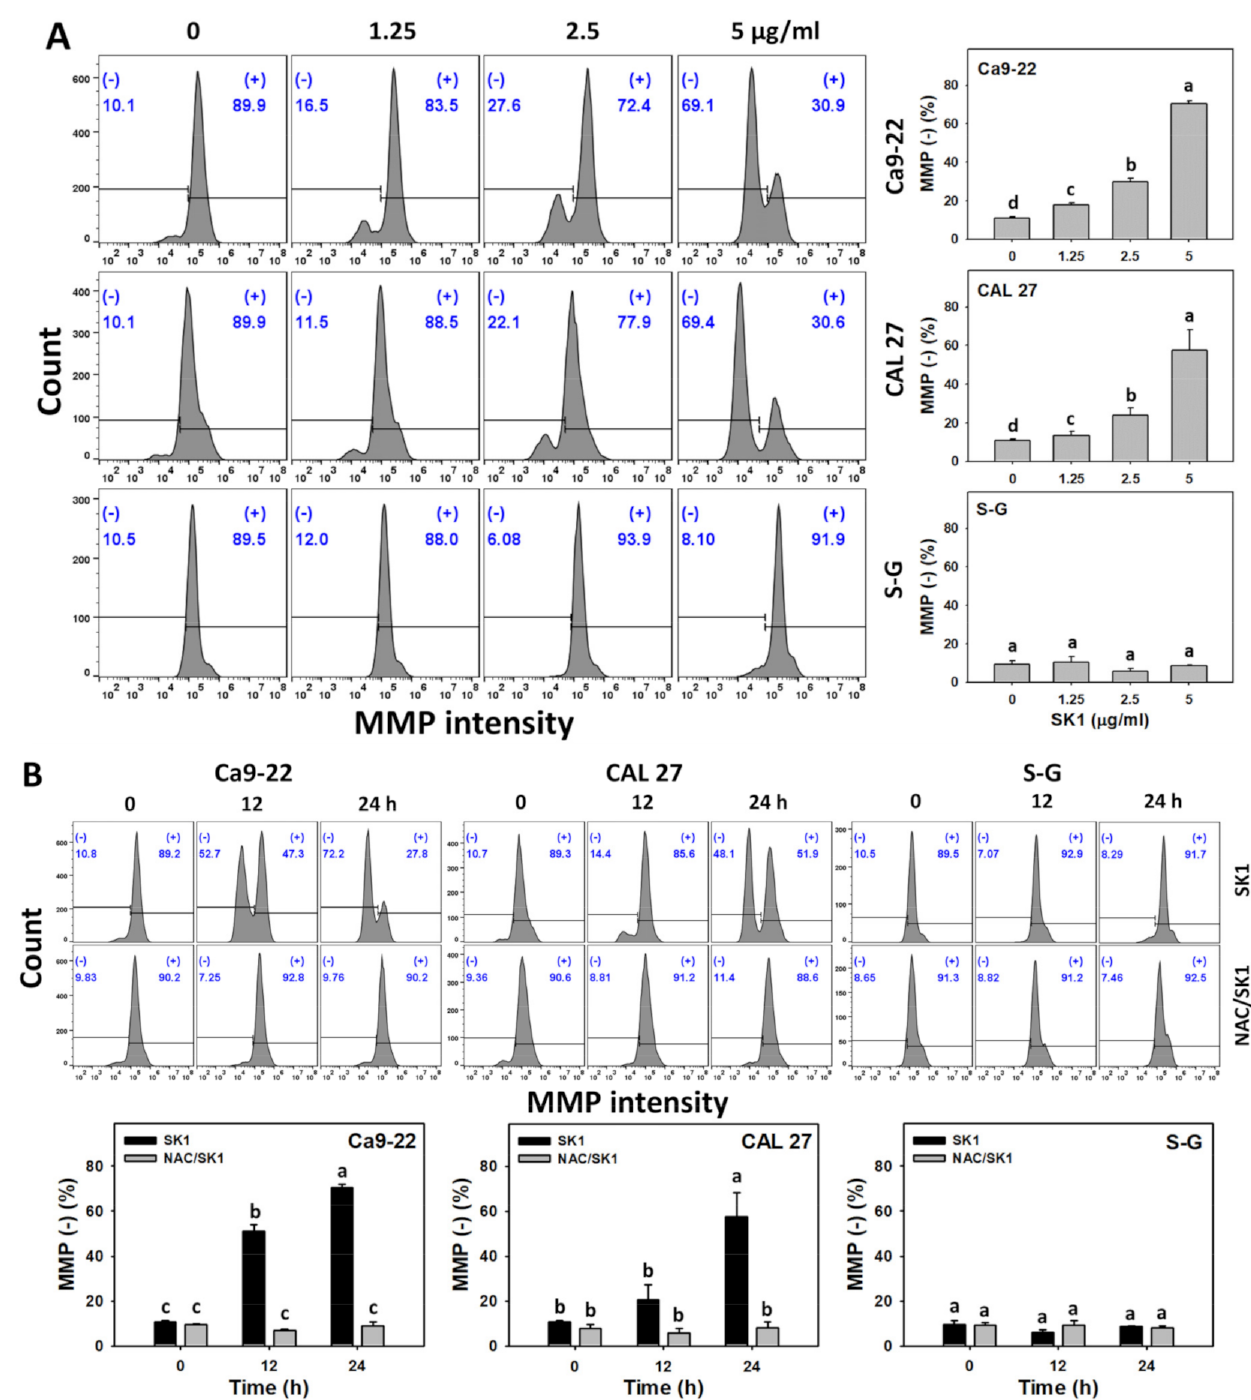
Figure 7. Oxidative stress effects (MMP) of SK1. ( A ) MMP assays of SK1. Non-malignant (S–G) and oral cancer (Ca9-22 and CAL 27) cells were treated with SK1 (0 (0.1% DMSO in medium), 1.25, 2.5, and 5 µ g/mL) for 24 h. ( B ) MMP assays of NAC/SK1. NAC/SK1 indicated that cells were pretreated with NAC and posttreated with SK1 5 µ g/mL for 0, 12, and 24 h. ( − ) inserted at the histogram is counted for the percentage of MMP ( − )(%). Data, mean ± SD ( n = 3). Statistical software provided non-overlapping low-case letters indicate significant results for multi-comparison ( p <